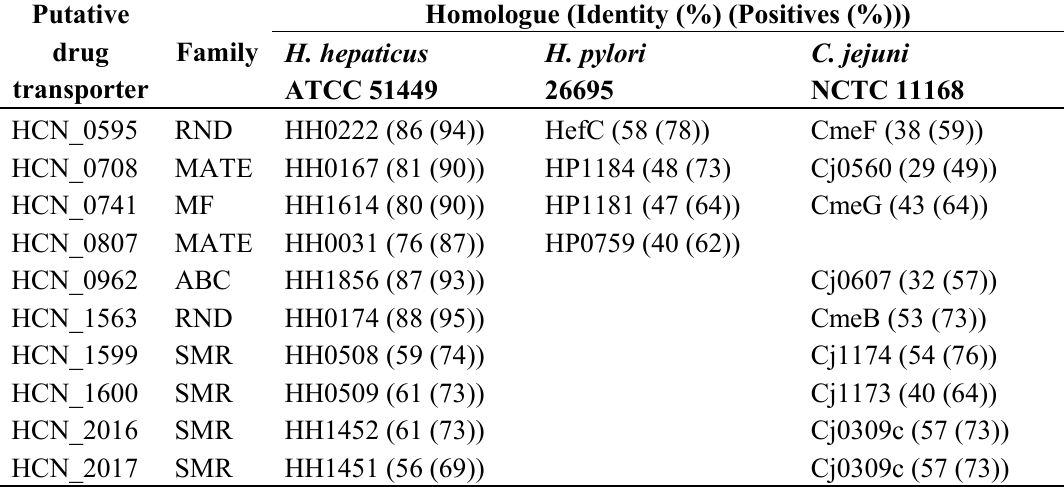
Table 1. Homologues in the other representative ε-proteobacteria for the putative drug efflux transporters of H. cinaedi PAGU 611. Homologues in H. hepaticus ATCC 51449, H. pylori 26695 and C. jejuni NCTC 11168 for the putative efflux transporters of H. cinaedi PAGU 611 are shown using BLAST